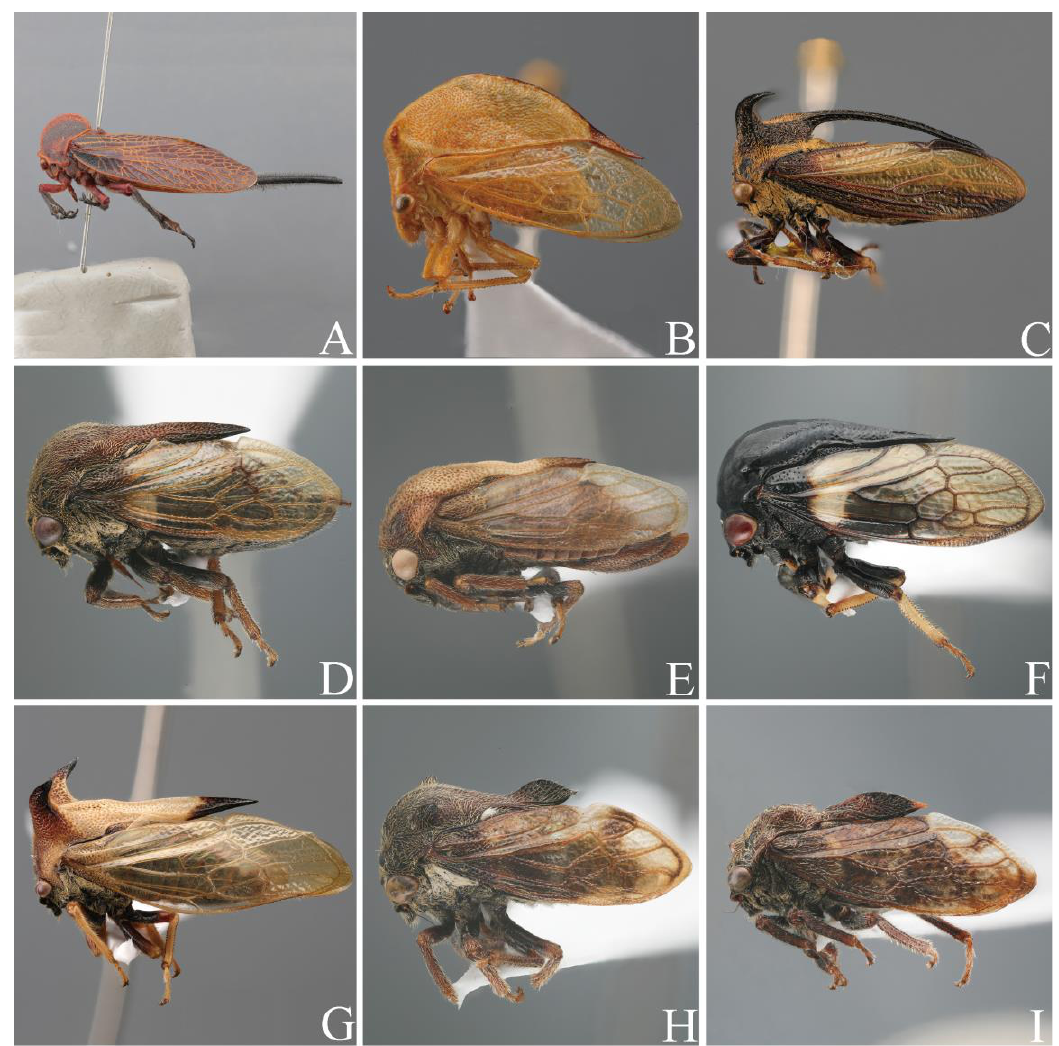
Figure 1. Specimens representative of Membracidae: ( A ) Darthula hardwickii (Aetalioninae: Darthylini); ( B ) Stictocephala bisonia (Smillinae: Ceresini); ( C ) Leptocentrus albolineatus (Centroti- nae: Leptocentrini); ( D – I ) Centrotoscelus davidi , Kotogargara minuta , Tricentrus fulgidus , Tricentrus gammamaculatus , Antialcidas floripennae , and Machaerotypus stigmosus (Centrotinae: